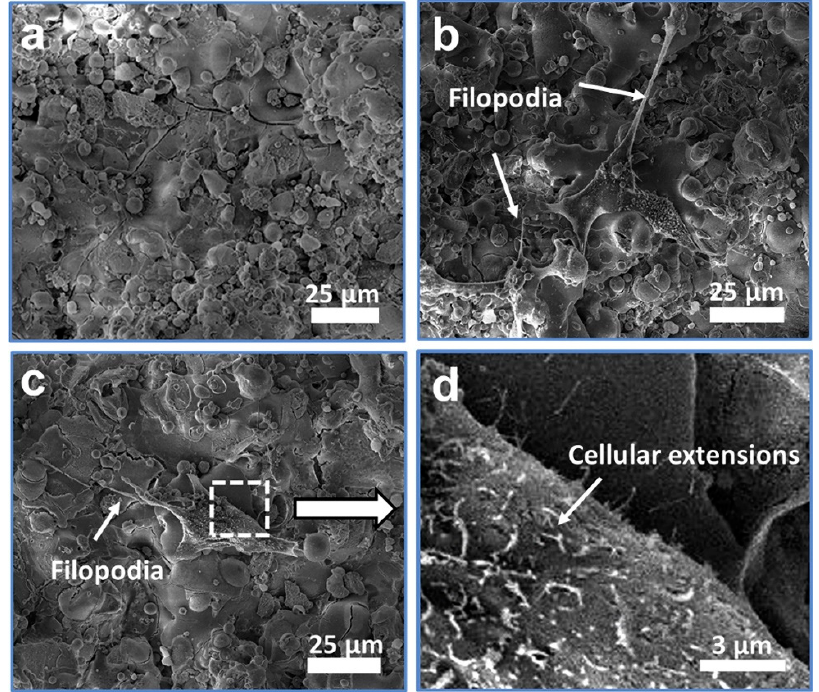
Figure 7. Micrographs of ( a ) the surface of the control group without cells and ( b – d ) cell morphology after culture on the (Mg, Sr)-HA coatings for five days. White arrows show filopodia of cells and cellular extensions. A large magnification ( d ) of the white dash box in ( c ) shows the cellular extensions [53]. Reprinted with permission from reference [53] 2018 Elsevier.